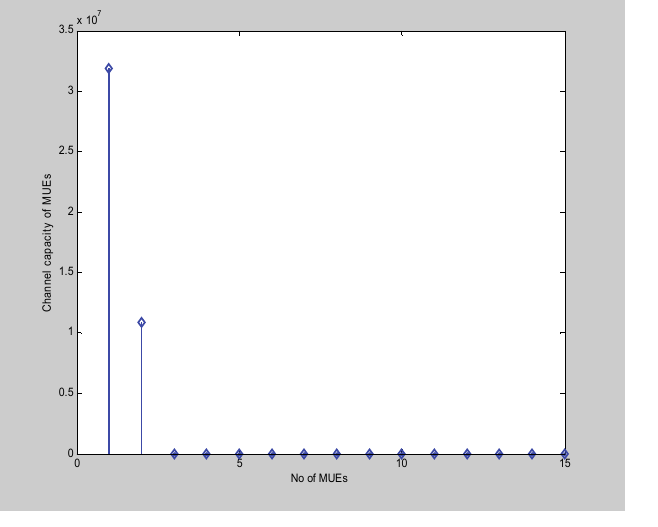
Fig. 10. Channel capacity of MUEs.